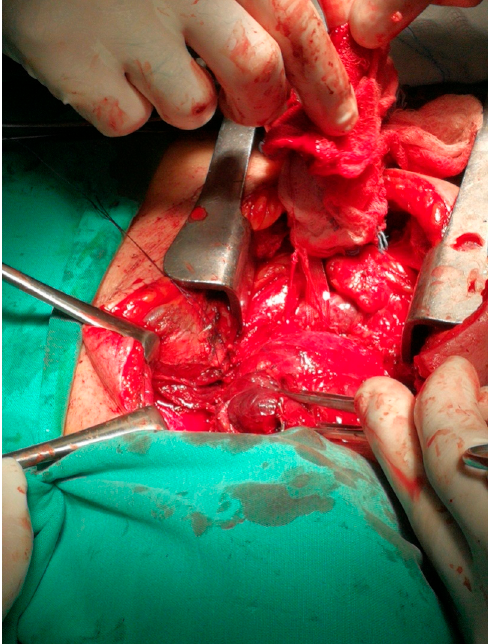
Figure 3. The combination of cervical incision and partial sternotomy (cervico-sternotomy) or the removal of the substernal goiter.